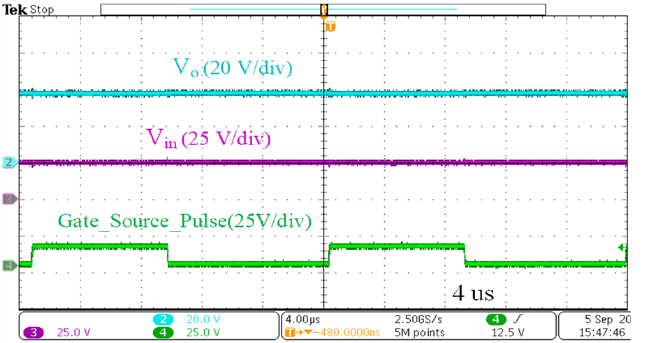
Figure 13. Boosting case study, where the input voltage is 25 V, output voltage is 38 V, duty cycle is 0.428, and voltage gain is 1.52.